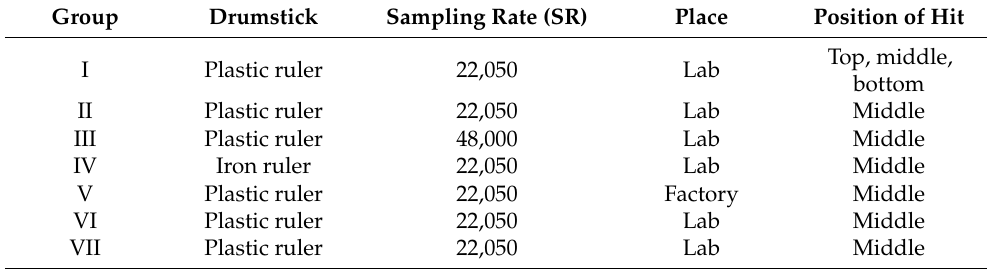
Table 3. Experiment condition.